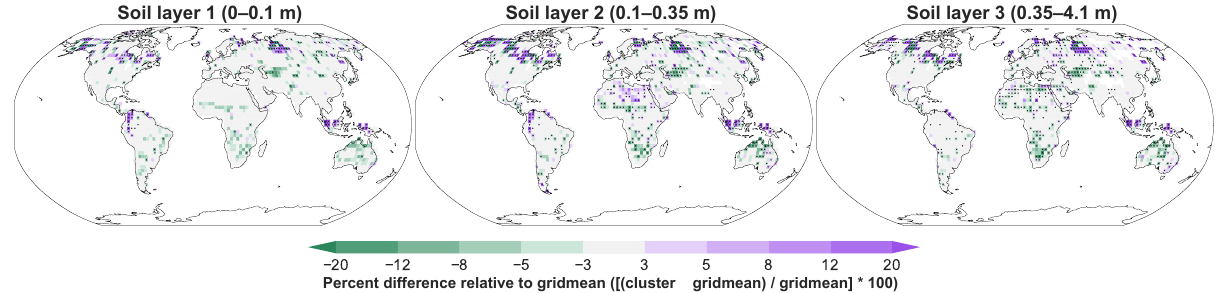
20 Percent difference relative to gridmean ([(cluster – gridmean) / gridmean] * 100) Figure 7. Percent difference in soil moisture per CLASS-CTEM soil layer between the Cluster and Gridmean simulations (mean of 1995– 2015). Grid cells with soil moisture below 10 − 5 kgm − 2 were masked out to prevent instances of division by zero and overly large relative differences in regions of very little soil moisture. Positive values indicate the Cluster soil moisture is larger while negative values indicate the Gridmean soil moisture is larger. Dots indicate grid cells that are statistically significant (independent two-sample t -test p level < 0 . 01).